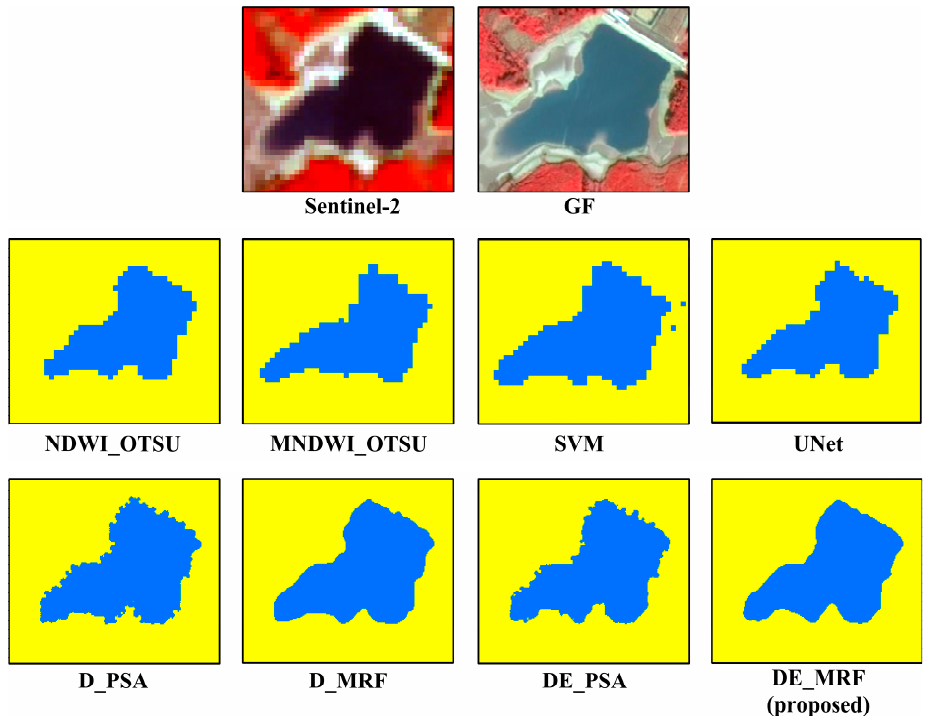
Figure 8. Zoomed-in area E in Figure 6 (the surface water maps predicted by different methods).